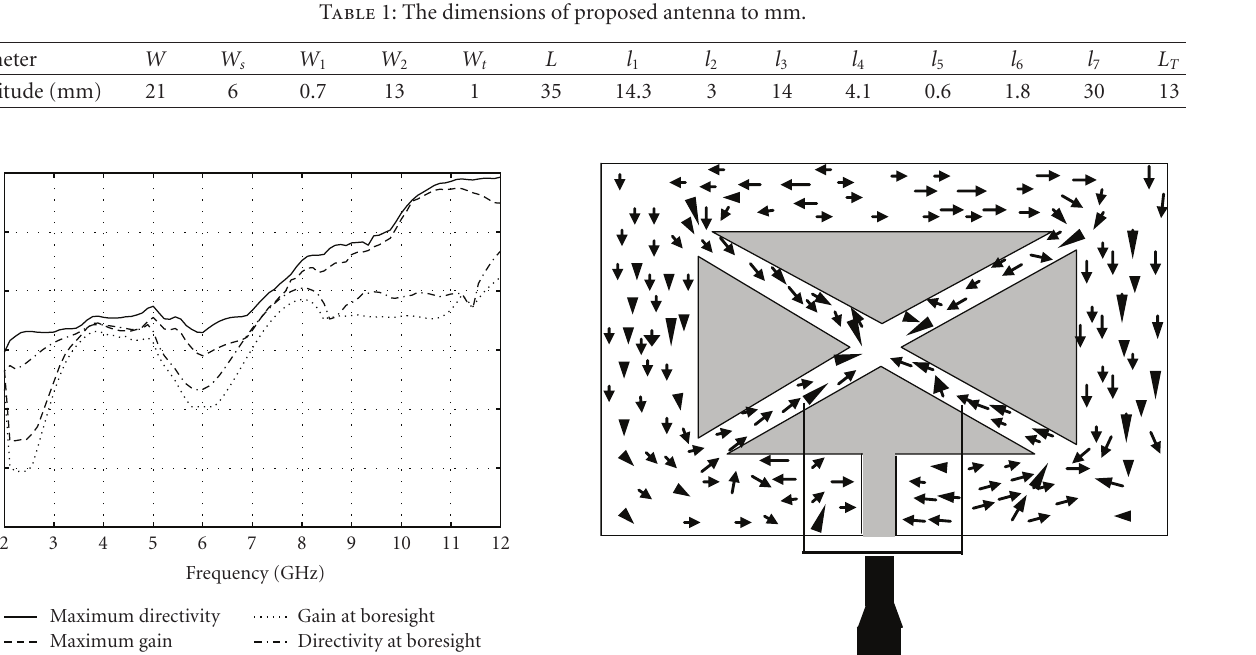
Figure 7: Simulated electric field distribution on the slots at the frequency of